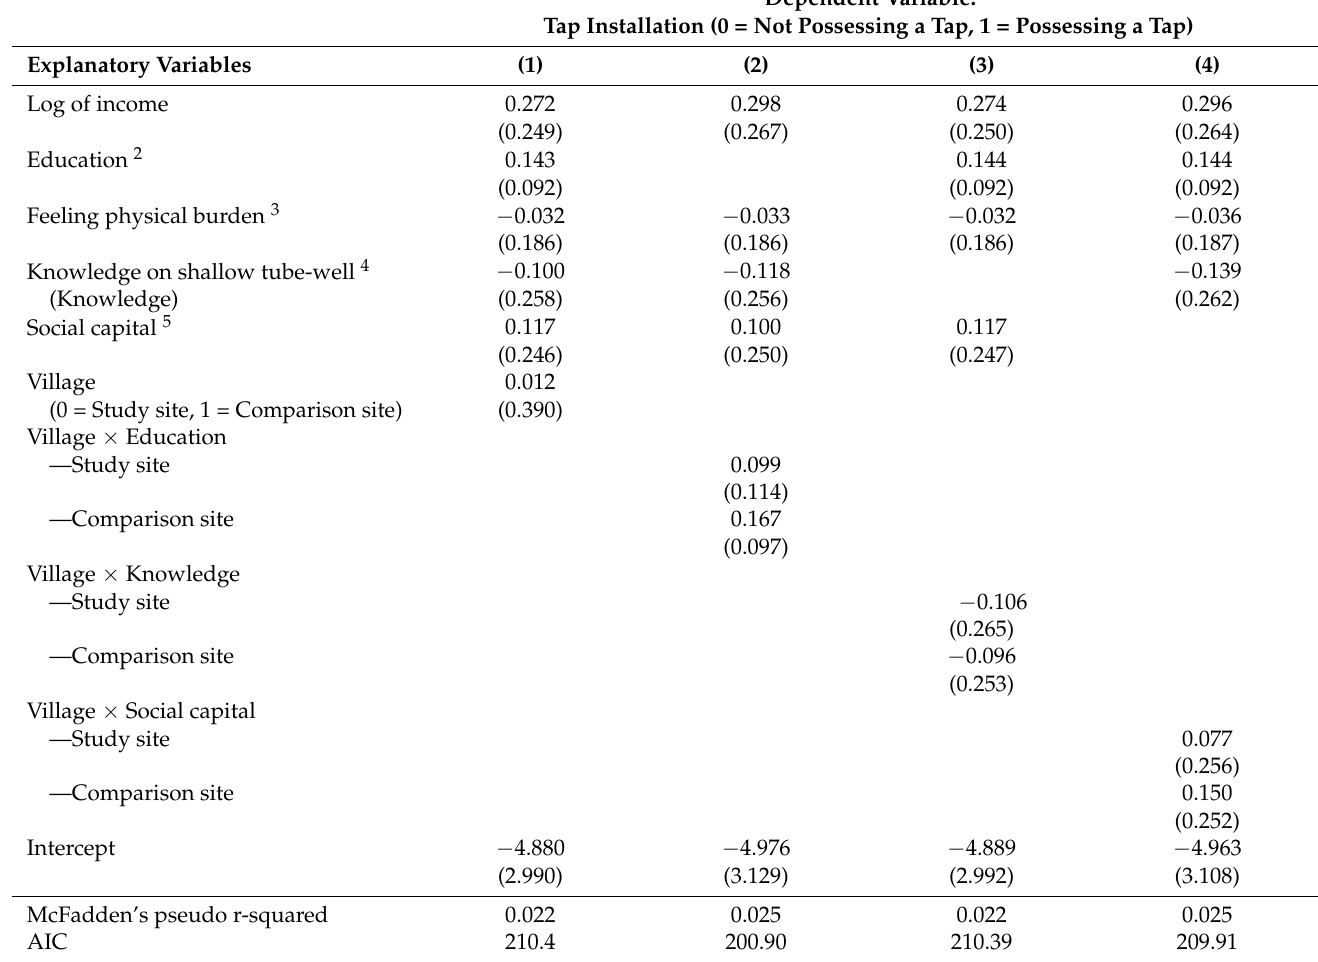
Table 5. Logistic regression results for determining likelihood of tap water installation (N = 257) 1 . Dependent